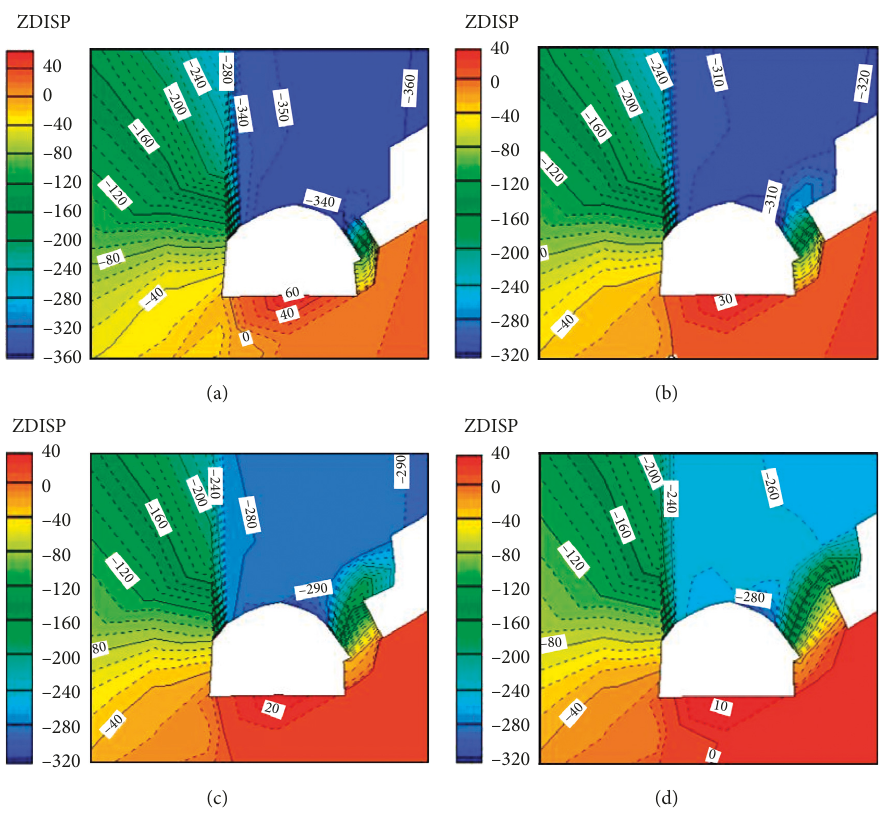
Figure 15: Vertical stress distributions of different GSSB widths: (a) 0.5m, (b) 0.75m, (c) 1.0m, and (d) 1.5 m.